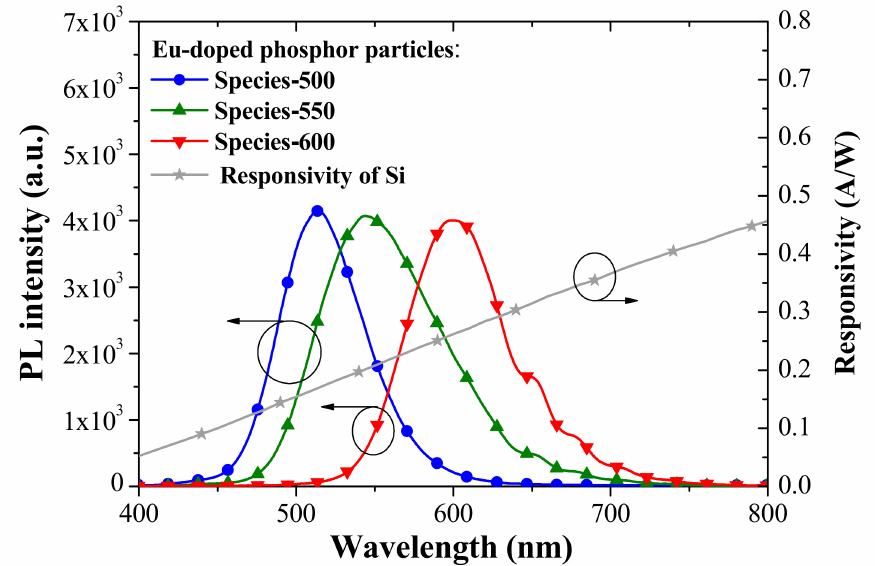
Figure 7. PL emission spectra of Eu-doped phosphors (species-500, species-550, and species-600) and corresponding responsivity of silicon p-n junction.